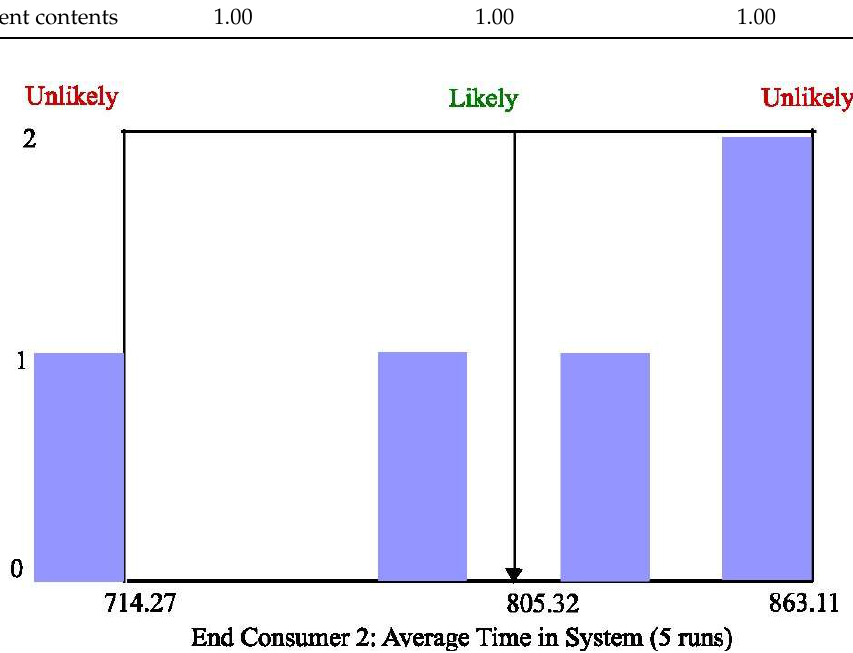
Figure 8. MORE plot for the average time in systems for end consumer 2.